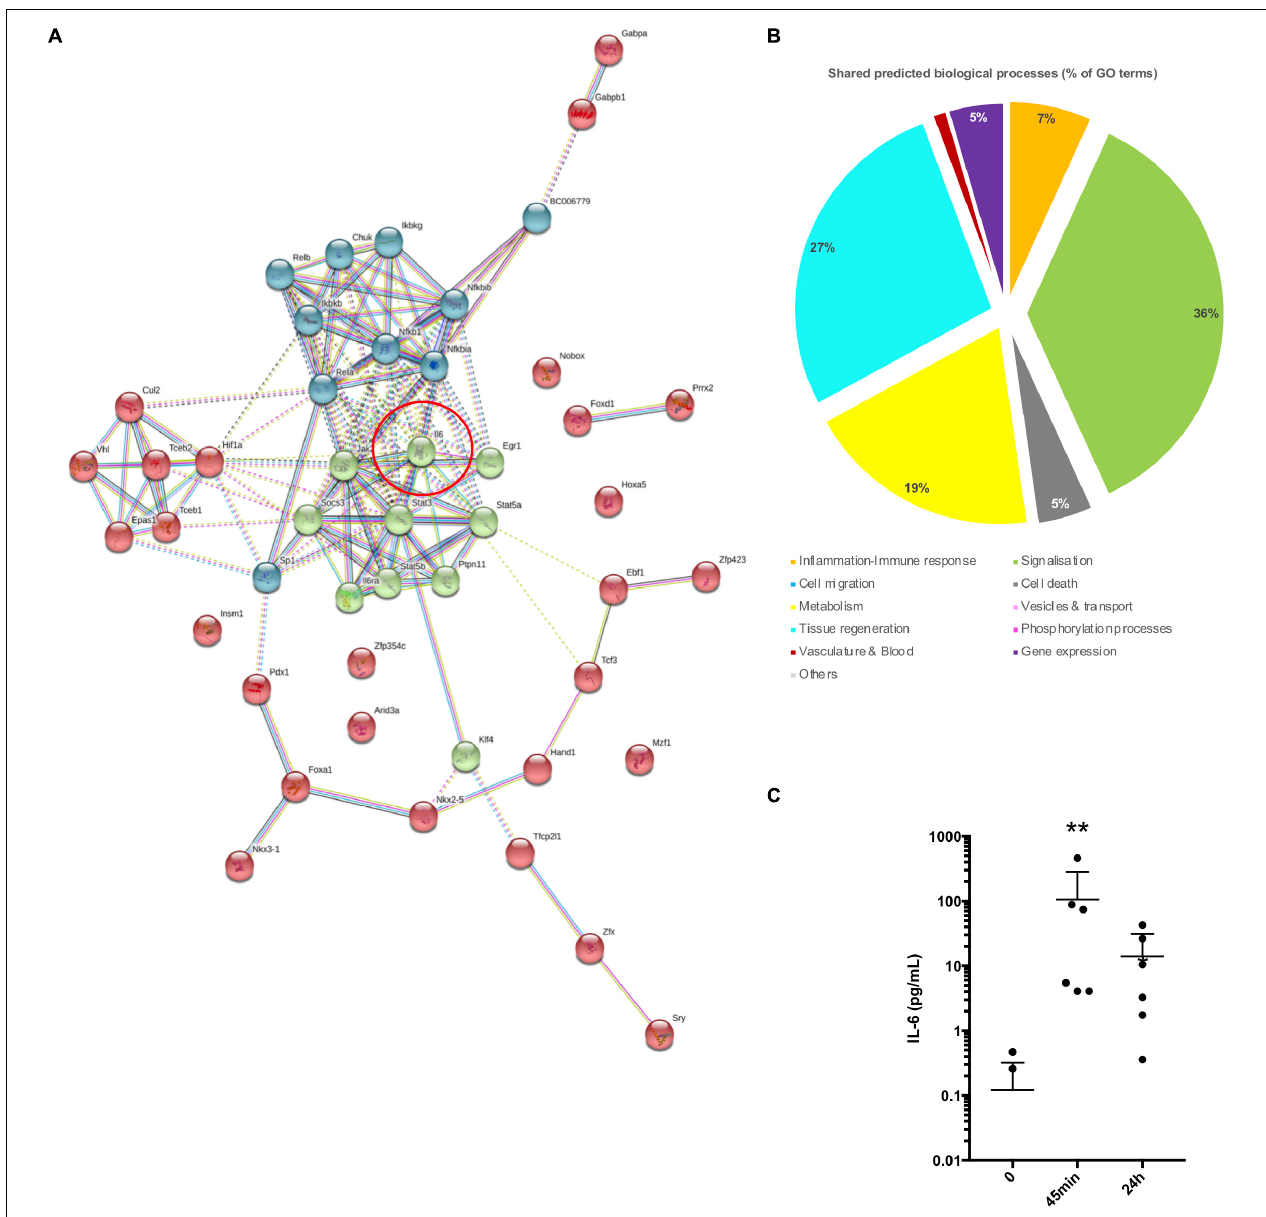
FIGURE 5 | Transcription factor analysis and PPI networks simulation. (A) TF-PPI network simulated by STRING from TFs group 3 and expanded for three layers (+20 neighbors). Line connections between proteins displaying the type of interaction. Red circle reports the central position of interleukin 6 in the network. (B) Pie chart showing the major biological processes expressed as the percentage of GO terms. GO terms predicted from the TF-PPI network shown in (A) and shared in the list of GO terms derived from were taken for this analysis. (C) Plot representing IL-6 concentration in the plasma of mice at 0 min, 45 min, and 24 h post-surgery ( n = 6 per time point) ( ∗∗ P ≤